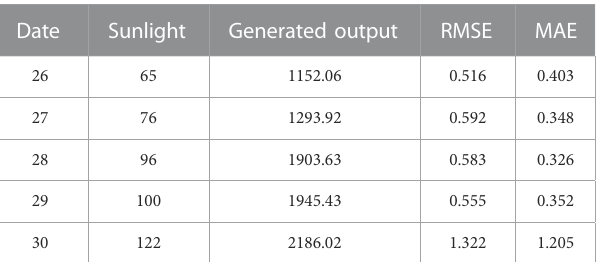
TABLE 3 Comparison diagram of 5-day error